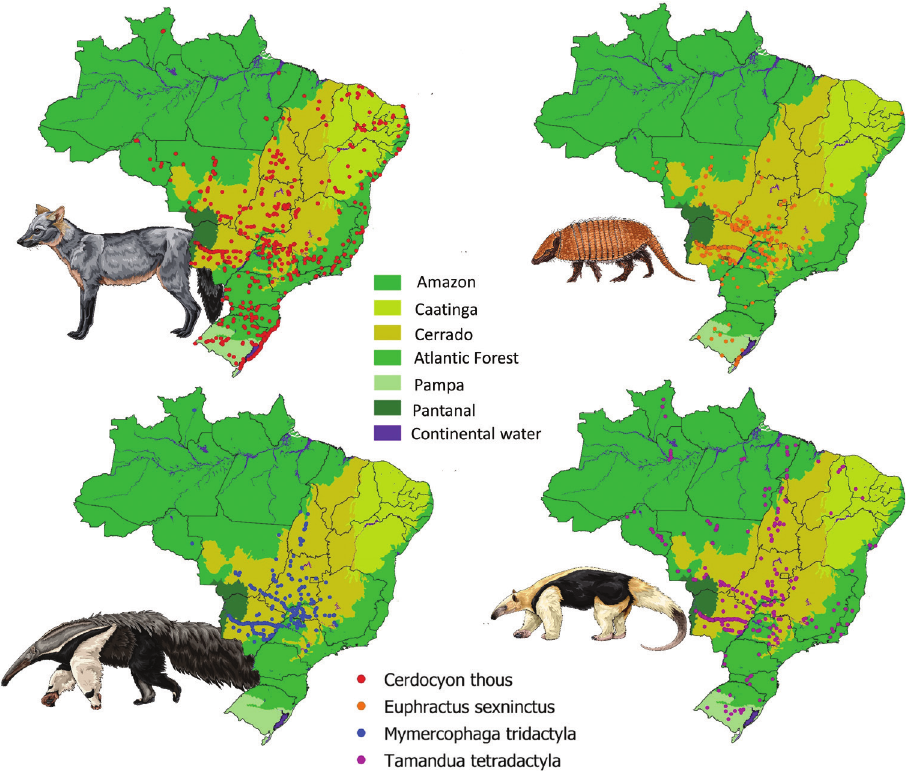
Figure 2. Roadkill samples distribution for the species studied. Cerdocyon thous represents the majority of roadkill samples, covering the entire territory. The other three species have samples aggregated in central Brazil, mostly in the Cerrado ecosystem.